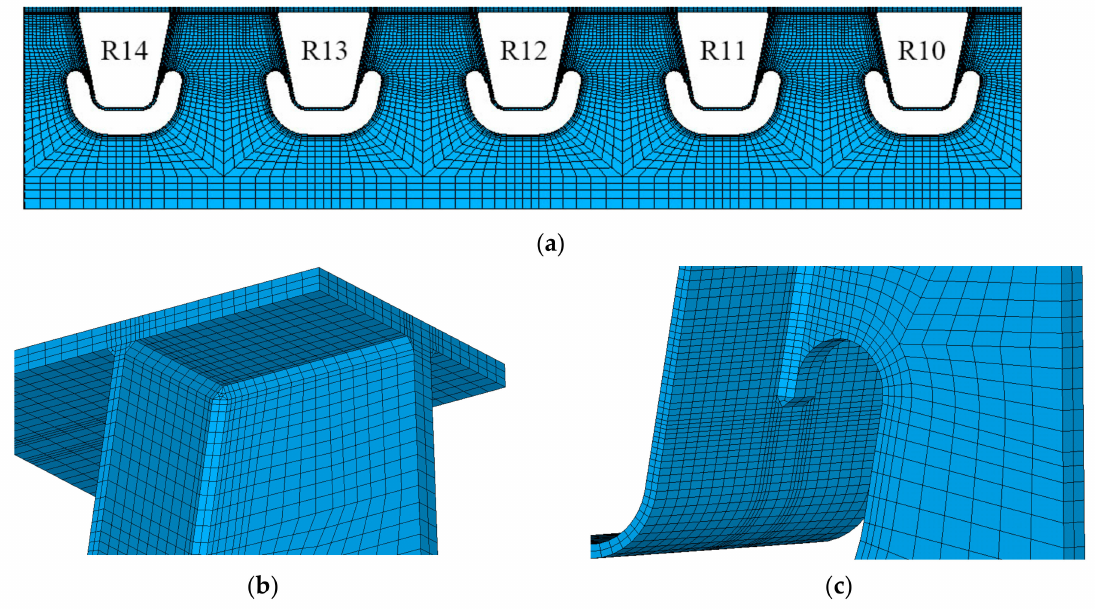
Figure 14. Mesh arrangement. ( a ) OSD panel; ( b ) Close view around RD weld; ( c ) Close view around RF